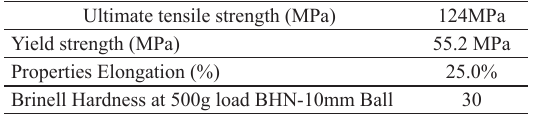
Table 2. Mechanical Properties of Graphite, Aluminium oxide, silicon carbide and boron carbide